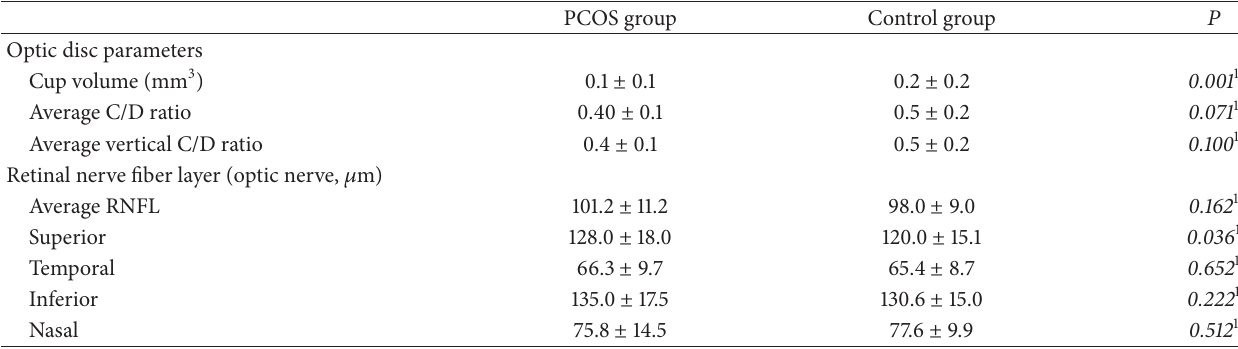
Table 3: The optic disc parameters and RNFL thickness around the optic nerve using HD-OCT: comparison between PCOS and control groups.